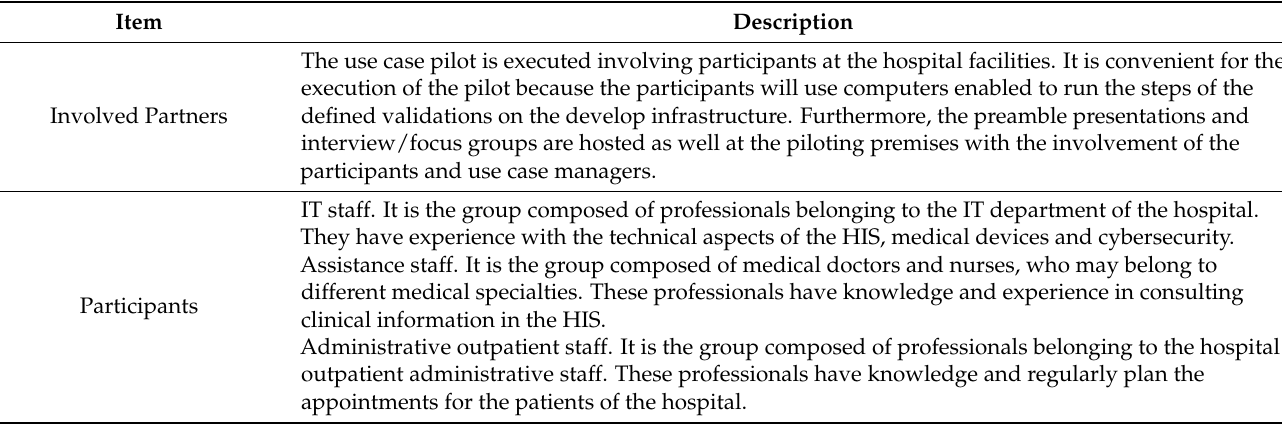
Table 4. Use case pilot plan